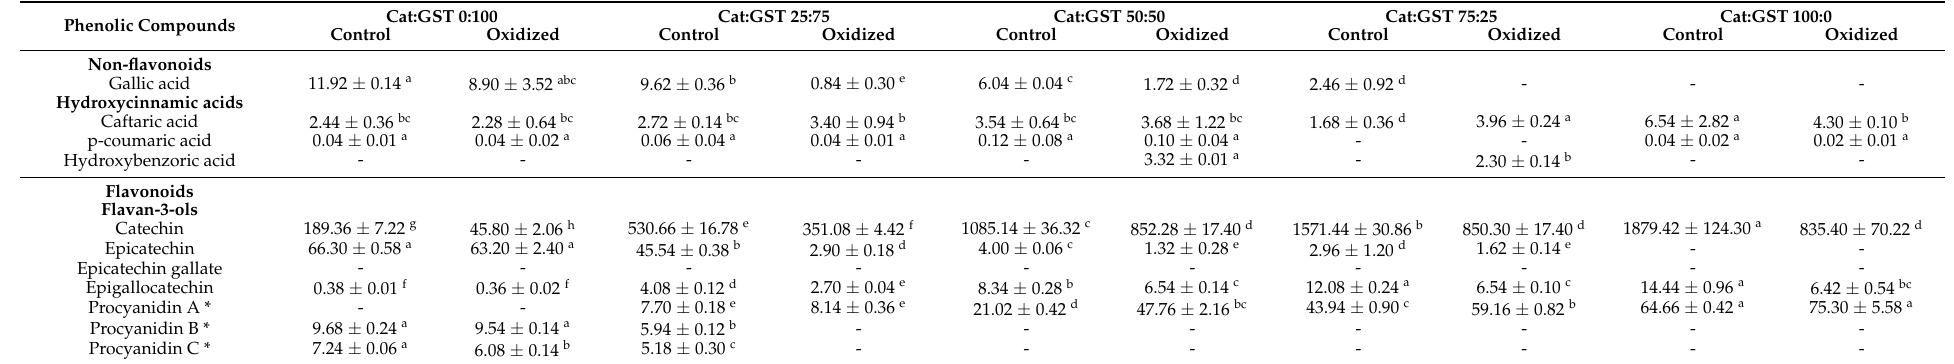
Table 3. Phenolic profile of flavonoid model (control and oxidized) (ppm) quantified by HPLC analysis.